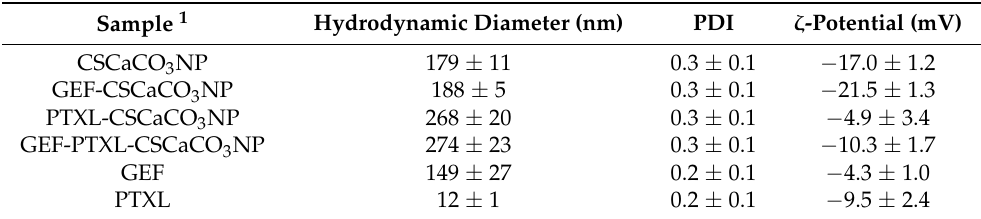
Table 3. DLS results showing the apparent hydrodynamic diameter, polydispersive Index (PDI) and zeta